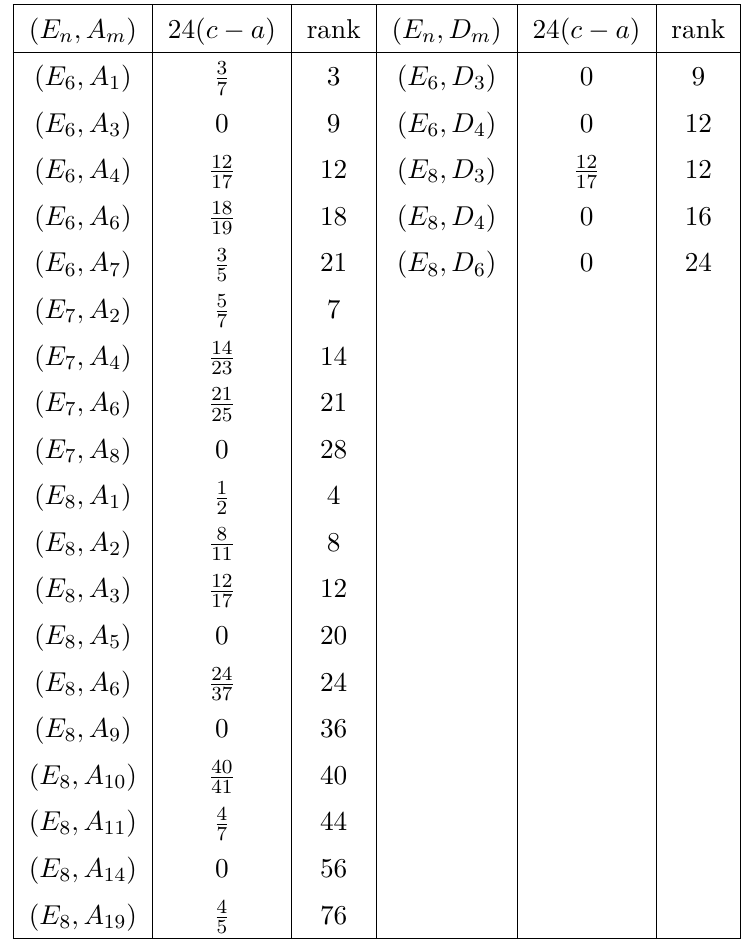
Table 4. ( E n , A m ) and ( E n , D m ) , with n = 6 , 7 , 8 and 1 ≤ m ≤ 100 .